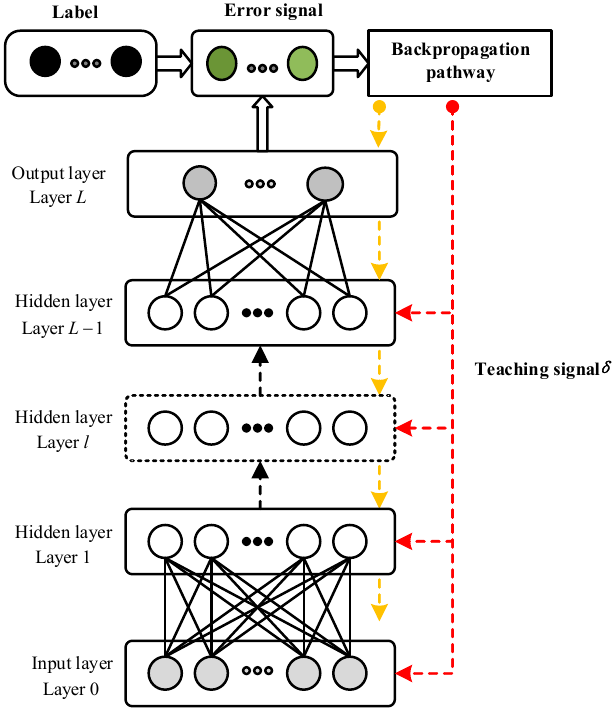
Figure 1. The DSNN architecture and error backpropagation pathway.